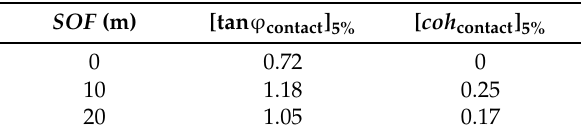
Table 14. Five percent fractile values for average strength parameters.